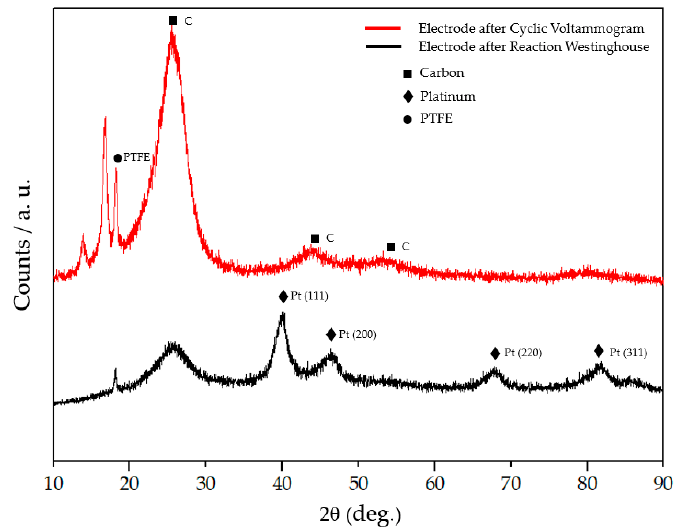
Figure 5. XRD patterns of Pt/C 40/60 electrode former used in Westinghouse process. Black lines